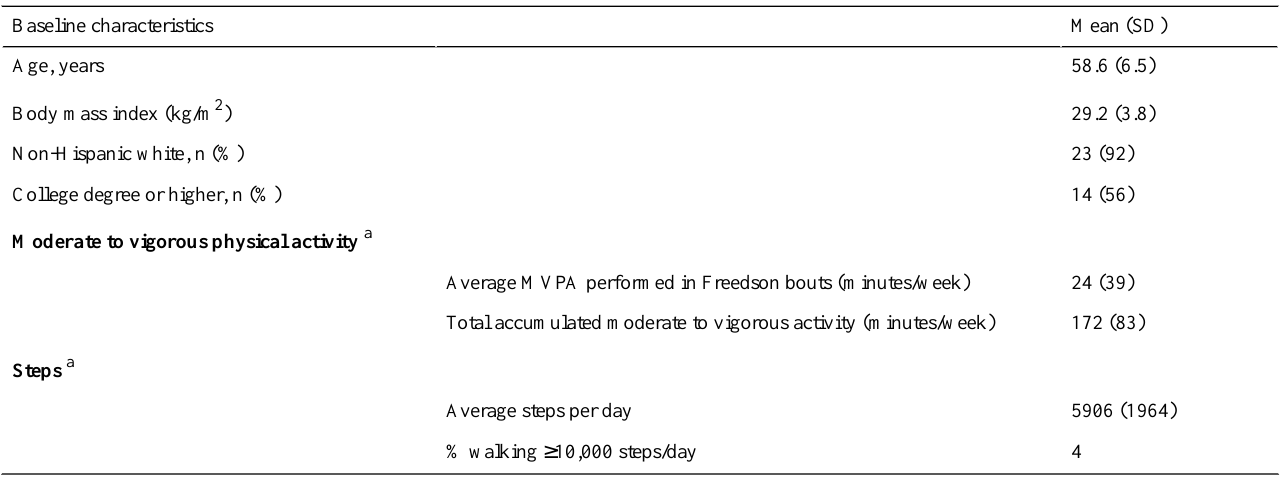
Table 1. Baseline characteristics of study participants